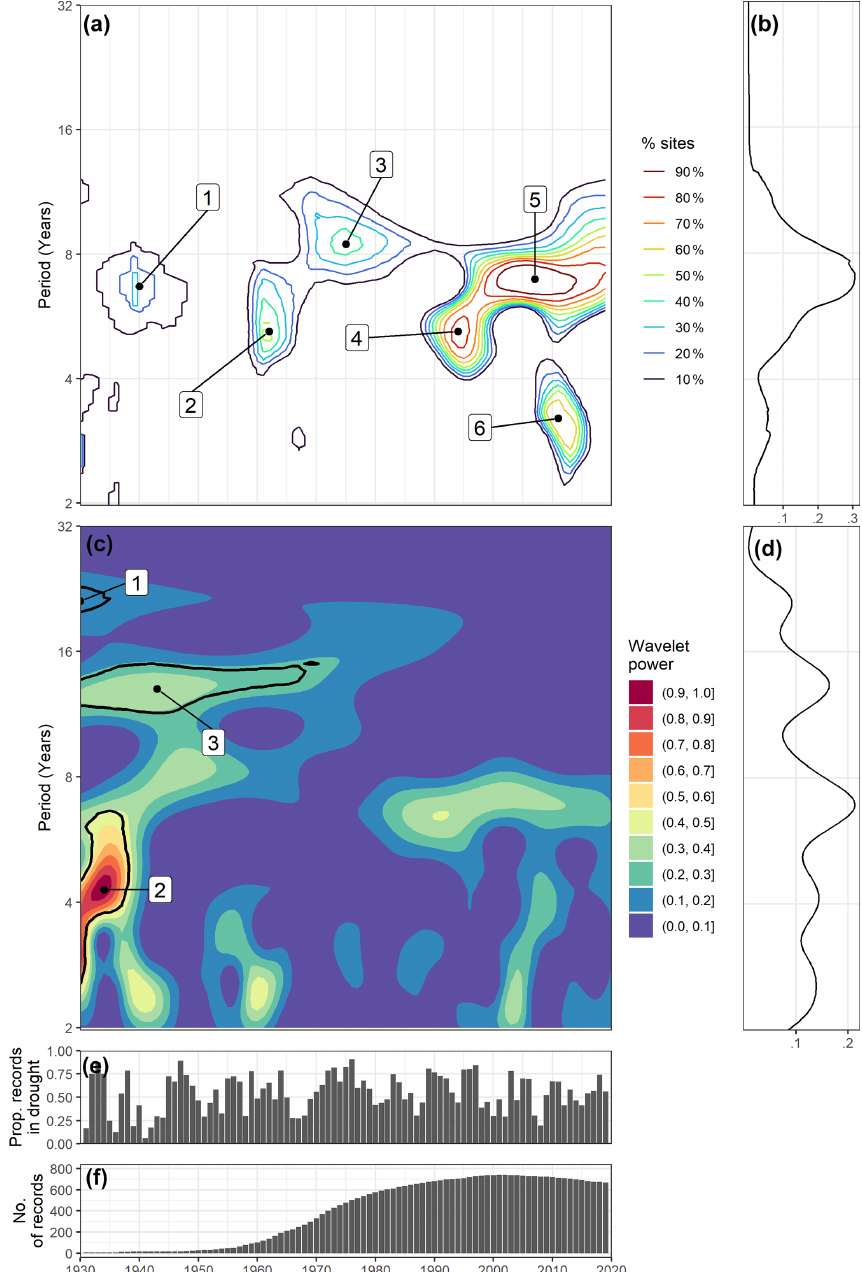
Figure 3. (a) Significance (95% CI) contours between SF and NAOI, (b) time-averaged proportion of SF records with a significant XWP with the NAOI (measured as a decimal fraction), (c) wavelet (spectral) power of SF drought series, (d) time-averaged wavelet (spectral) power of SF drought series, (e) SF drought series showing proportion of records in drought each year and (f) temporal coverage of